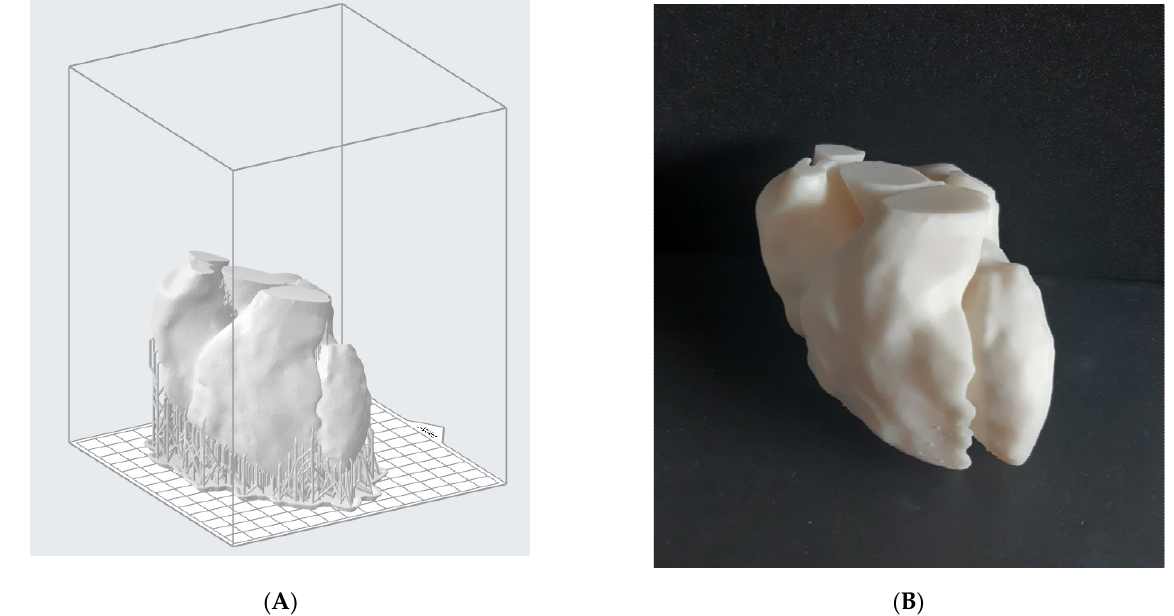
Figure 5. ( A ) Reconstructed digital model of the blood pool disposed onto the printing platform (Preform 3.3). We can appreciate the support structures that guarantee the printability of the model; ( B ) the corresponding printed result, after support removal and post-processing.